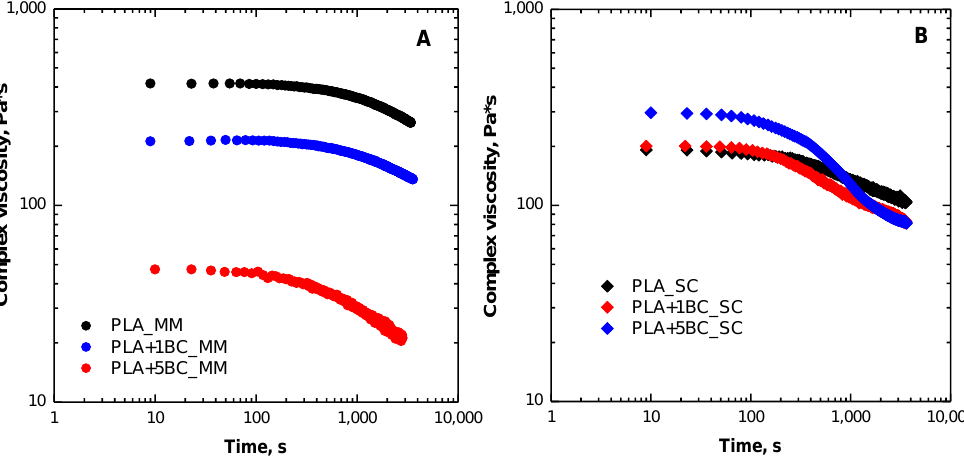
Figure 3. Time evolution of the complex viscosity at 170 °C for neat PLA and BC-containing composites obtained through melt mixing ( A ) and solvent casting ( B ).